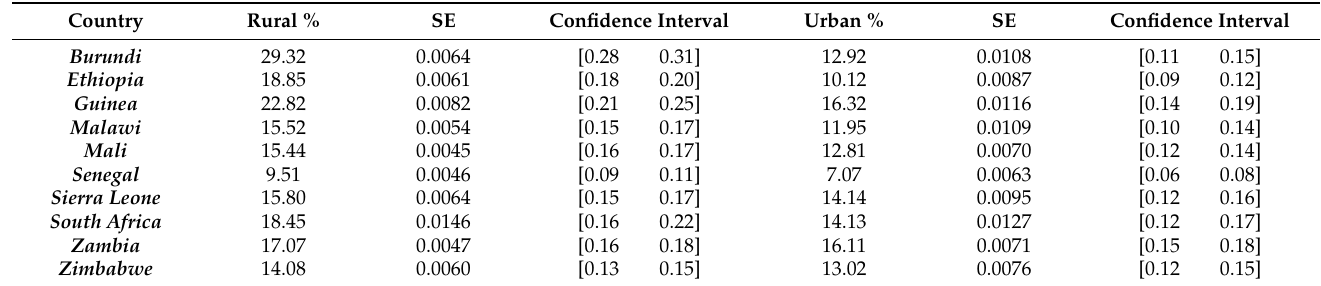
Table 2. Estimated prevalence of children who experience DBM by residence status.